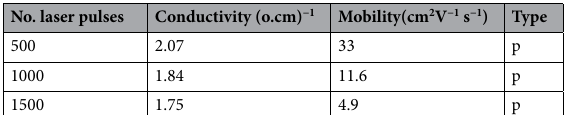
Table 2. Effect of number of laser pulses on electrical conductivity and mobility of B 4 C film.